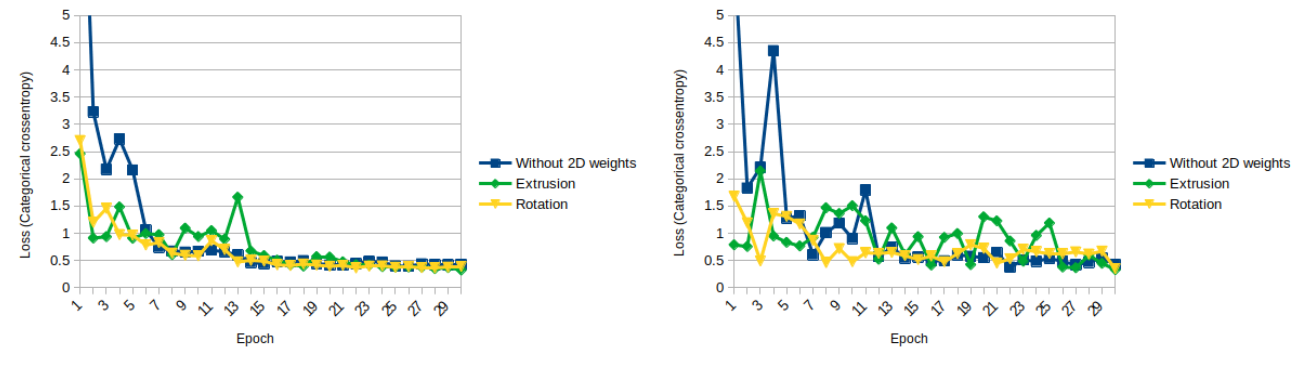
Figure 11. ResNet 3D Loss (Categorical